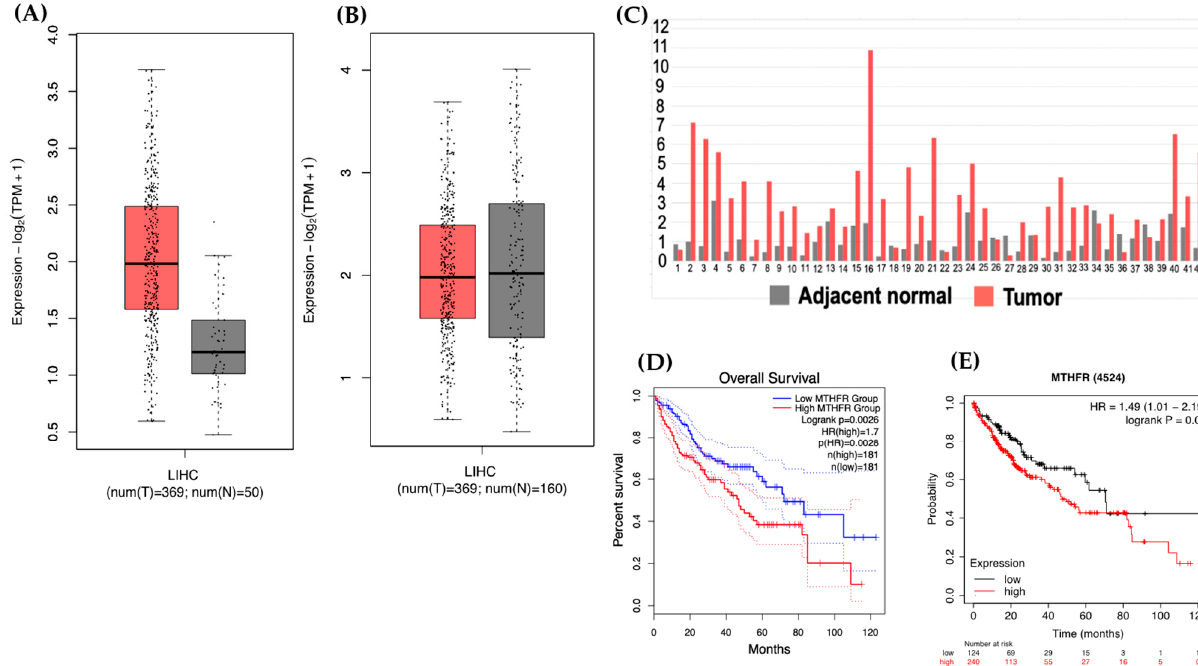
Figure 1. Reduced survival in patients whose tumor had higher MTHFR mRNA expression. ( A ) Box plots of MTHFR mRNA expression in HCC tissues (red) and the normal data from the TCGA database (gray); ( B ) Box plots of MTHFR expression of HCC tissue (red) compared to the normal data from the TCGA plus GTEx (gray); ( C ) Bar graph of MTHFR gene expression in paired HCC tumor and tumor-adjacent normal tissues from the Cancer RNA-Seq Nexus. The X -axis indicates the anonymous patient ID ( n = 42); and the Y -axis indicates the fold change of MTHFR mRNA expression level (fragments per kilobase per million, FPKM) in the HCC (red) compared to those in the matched adjacent normal tissues (gray). Thirty-three out of the 42 HCC tissues had MTHFR overexpression in the tumor compared to its paired normal tissue; ( D ) Kaplan–Meier plots were generated from the Pan-cancer RNA-Seq Web server ( D ) and the GEPIA website ( E ). Both plots suggested that an increased MTHFR mRNA was significantly associated with poorer survival in HCC